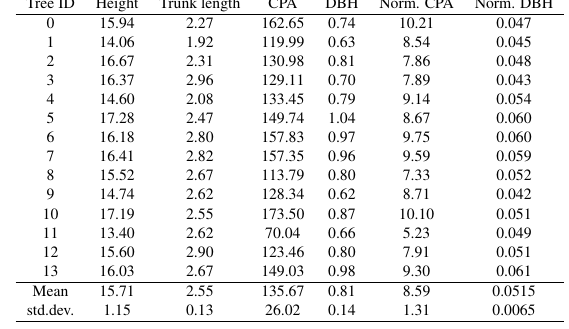
Table 1: Tree parameter estimation results from the trees of